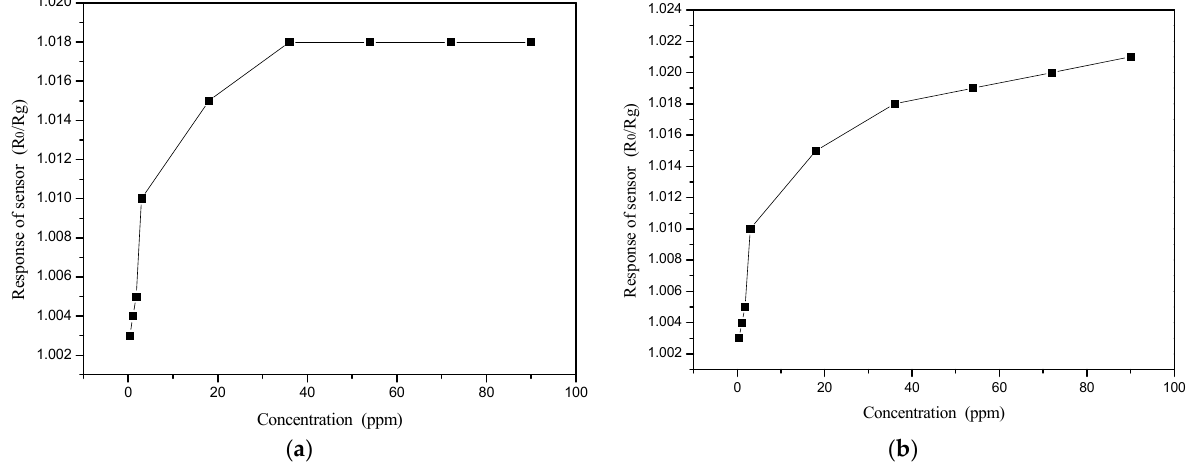
The change in the PANI and PANI/SnO 2 gas sensor response curves with benzene